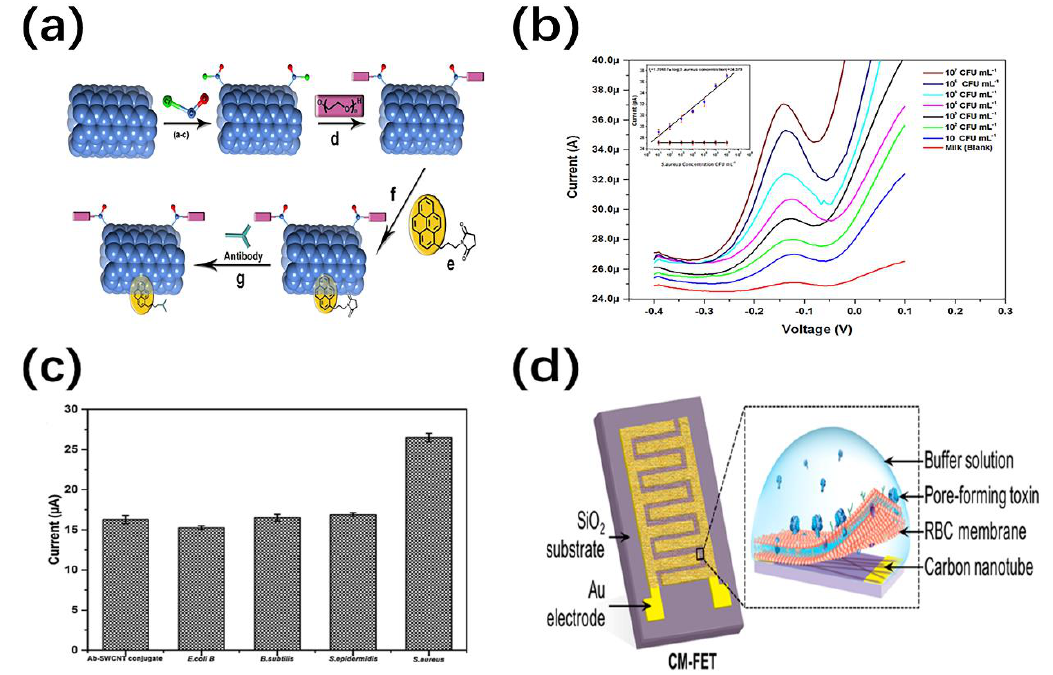
Figure 8. ( a ) Schematic illustration of the synthesis of modified MWCNT [94]; ( b ) the current versus voltage under different S. aureus concentrations from 10 to 10 7 colony-forming units (CFU) mL −1 in milk sample [95]; ( c ) the Histogram of selectivity for S. aureus vs. E. coli B, B. subtilis, and S. epidermidis [95]; ( d ) schematic illustration of the cell-membrane-coated CNT field-effect transistor (FET) [96].